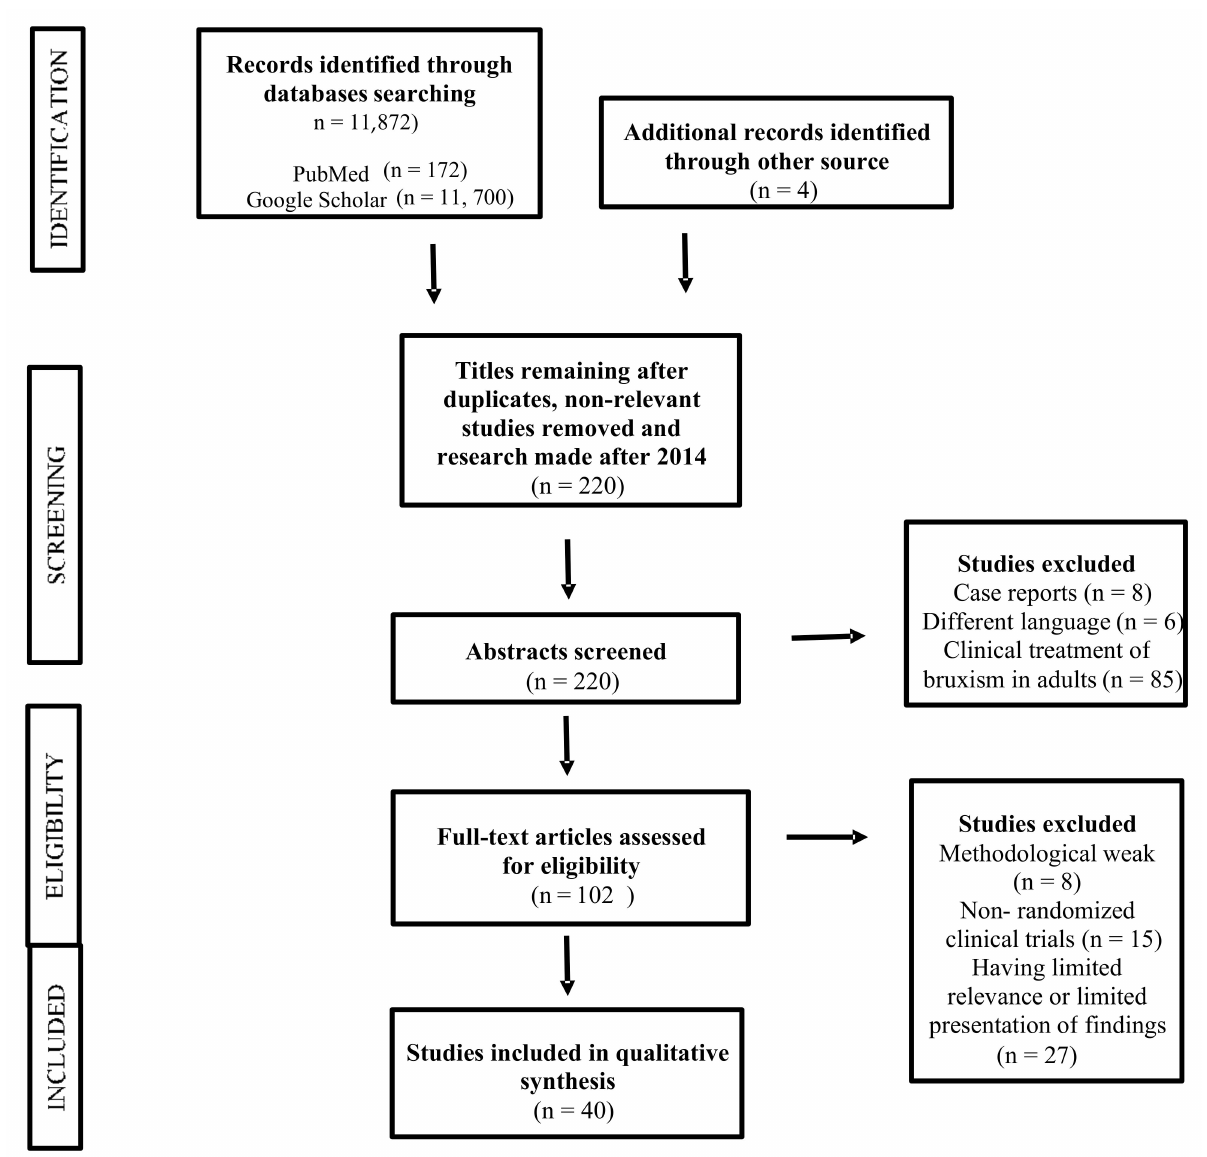
Figure 1. PRISMA flowchart for the systematic